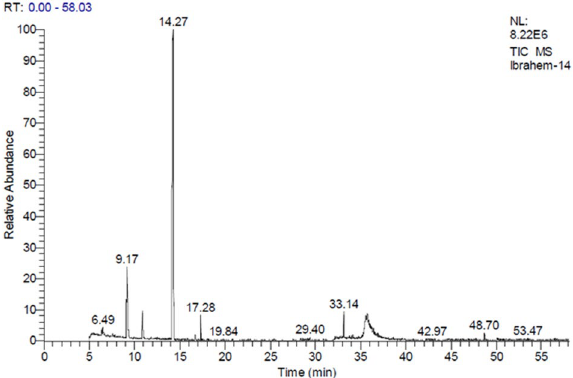
Figure 1. GC/MS analysis of the Foeniculum vulgare Mill.